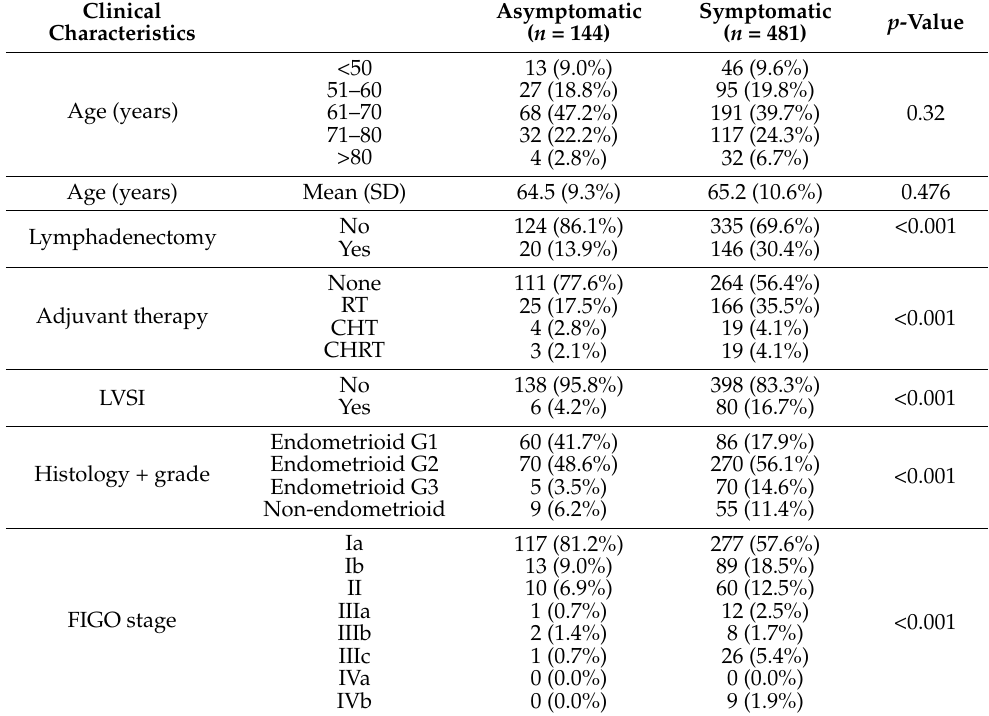
Table 1. Clinical patients’ characteristics.